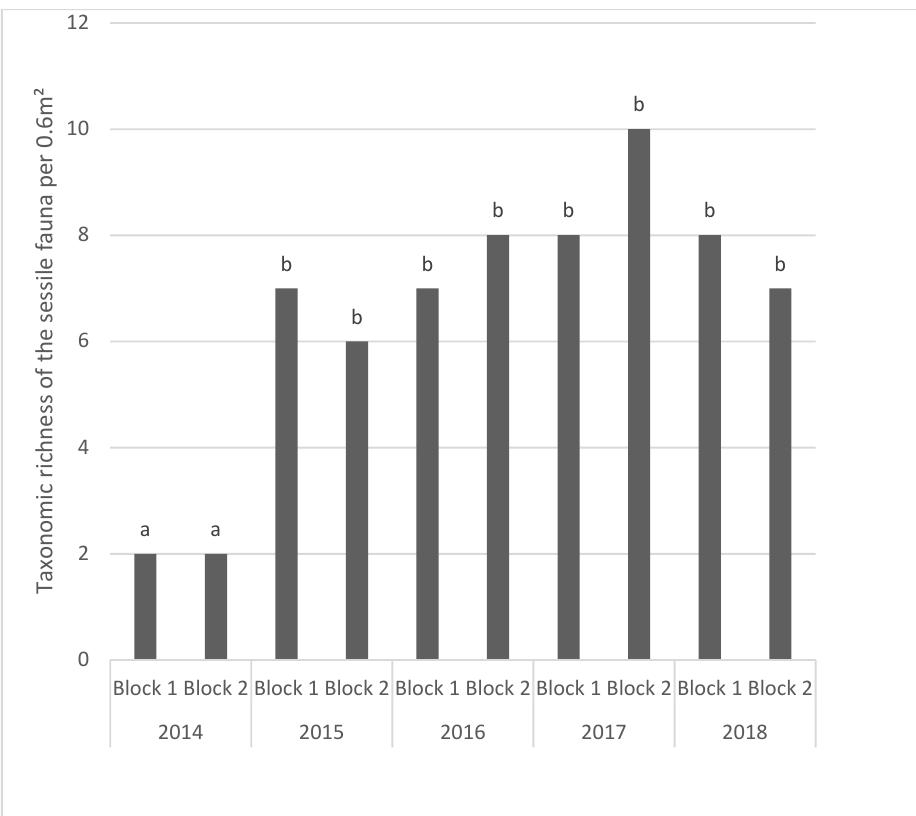
Figure 4. Taxonomic richness of the sessile fauna per 0.6 m 2 in the ten blocks sampled from 2014 to 2018, with results of the Tukey tests (superscript: same letters in adjacent columns indicate no significant statistical difference between blocks and years).